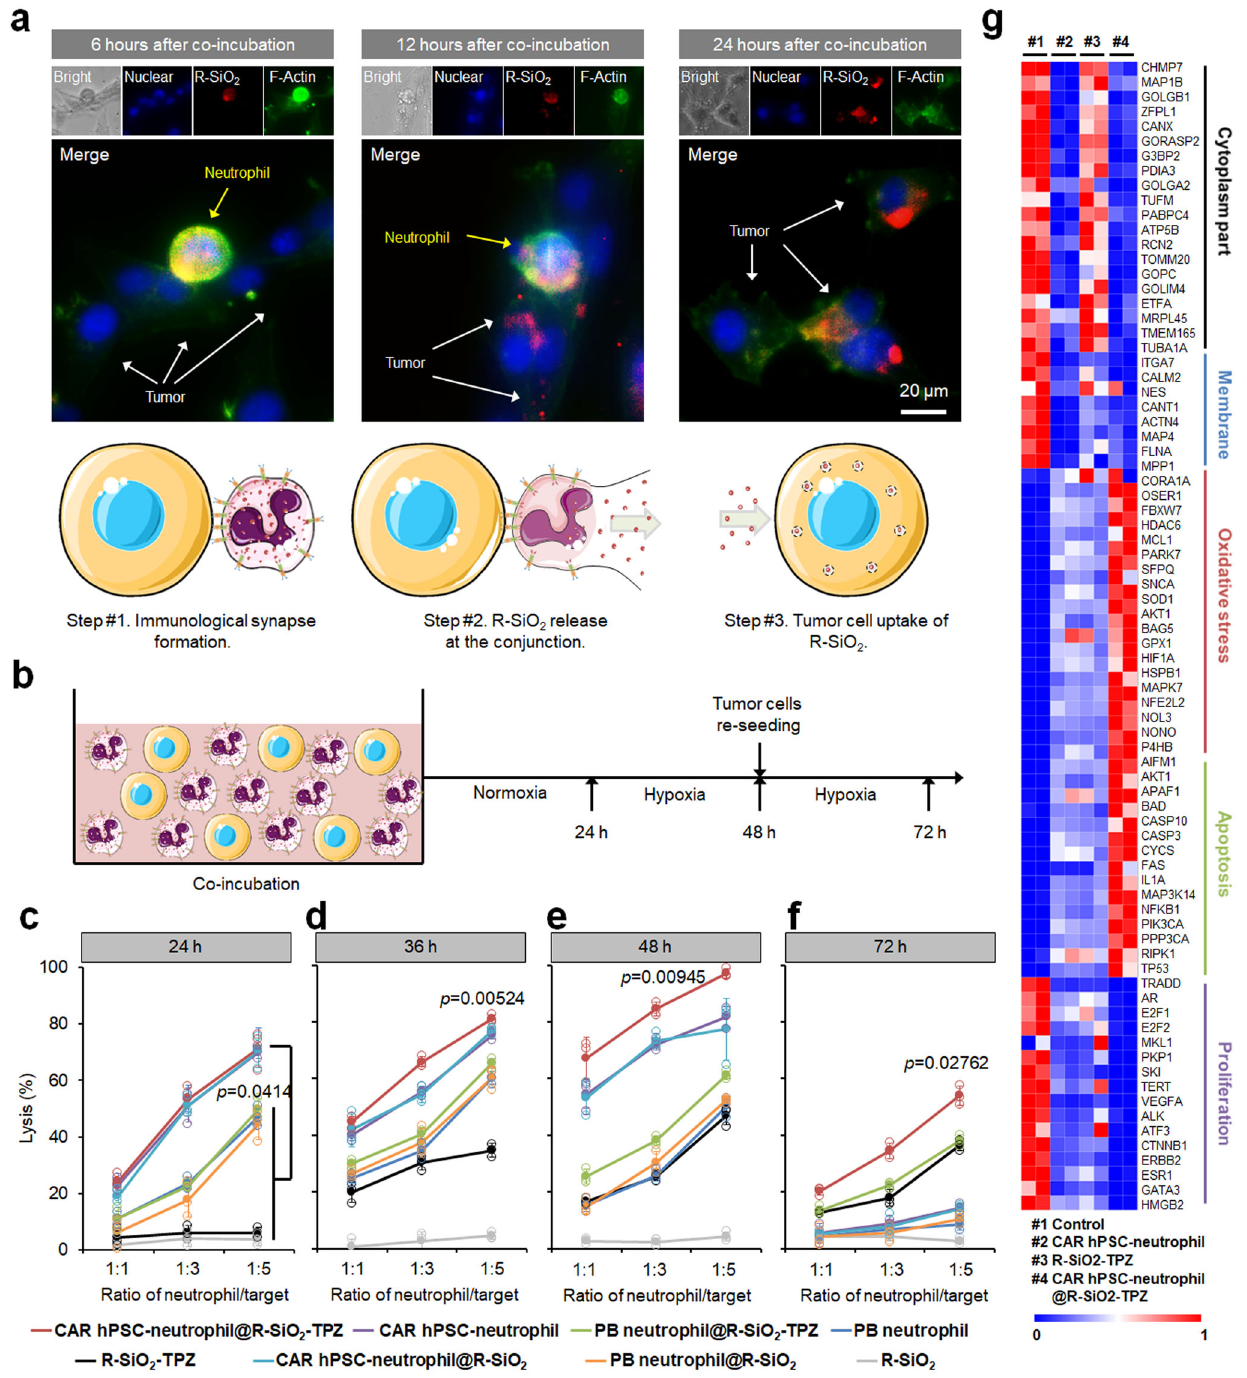
Fig. 4 | CAR-neutrophils loaded with R-SiO 2 -TPZ nanoparticles effectively kill glioblastomacells.a Representativeimagesofimmunologicalsynapsesindicated by polarized F-actin accumulation at the interface between CAR-neutrophils and tumor cells at 6, 12 and 24h were shown. R-SiO 2 -TPZ nanoparticles released from CAR-neutrophils upon tumor cell phagocytosis were up-taken by tumor cells. Triplicates were performed independently. b Schematic of neutrophil-mediated anti-tumorcytotoxicityassay.CytotoxicityagainstU87MGglioblastomacellswere performed at different ratios of neutrophil-to-tumor target using indicated